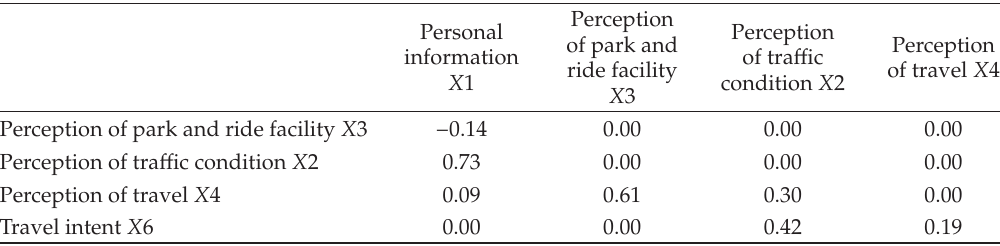
Table 3: The standard direct relationship.